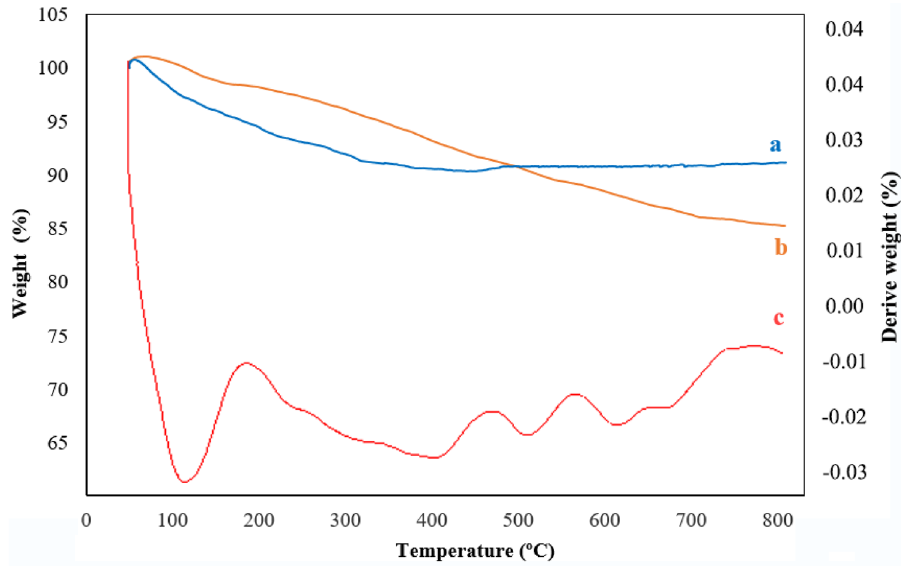
Figure 6. TGA curves of ( a ) SBA-15/Fe 3 O 4 , ( b ) the guanidinylated SBA-15/Fe 3 O 4 , and ( c ) DTGA of the guanidinylated SBA-15/Fe